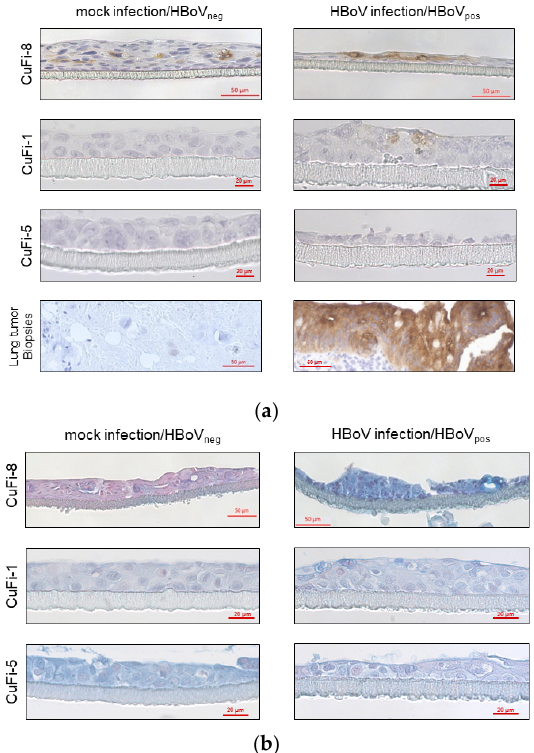
Figure 3. Immunohistochemical staining of CuFi-8 air–liquid-interface cultures. ( a ) Scheme 8. cells and HBoV-positive lung tumor biopsies, whereas mock-infected CuFi-8 cultures, as well as HBoV- negative lung tumors, were CEA-negative. CuFi-1 and Cufi-5 cells were not CEA-positive at all. ( b ) PAS–Alcian blue staining reveals higher production of acid mucins in CuFi-8 cells compared to those in CuFi-1 and CuFi-5 cells in general. Beyond that, there is an increased expression of acid mucins after HBoV infection in CuFi-8 cells.